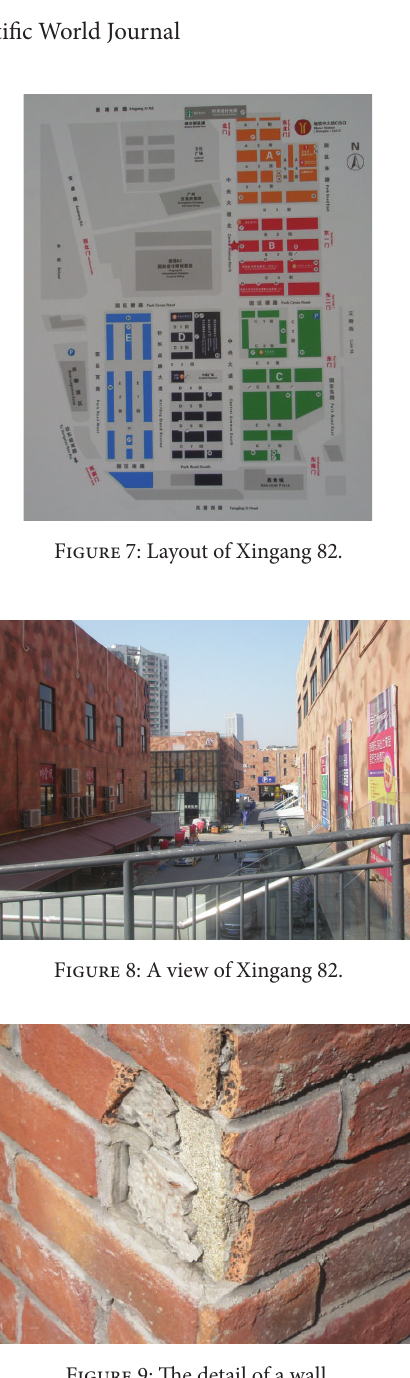
Figure 9: The detail of a wall.